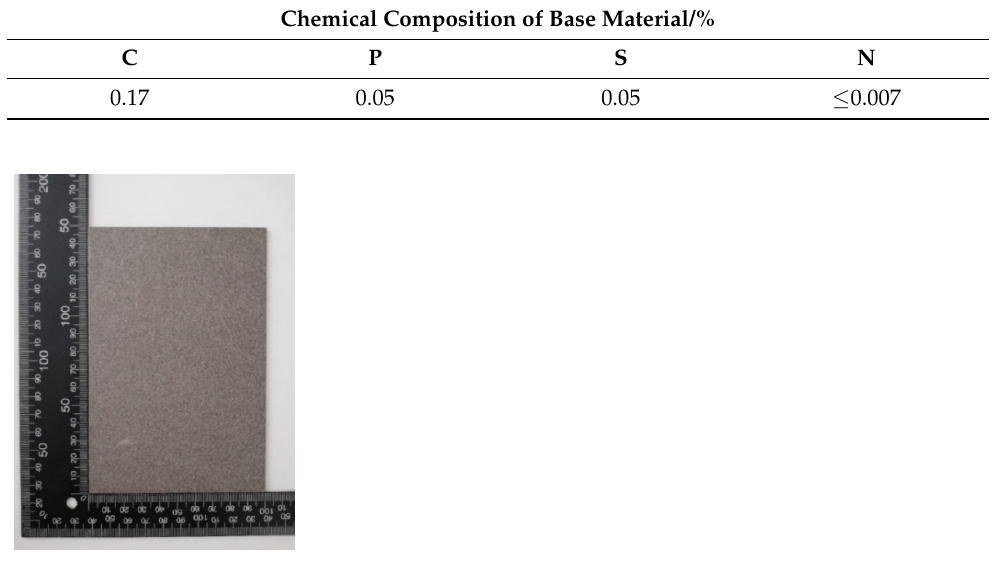
Figure 2. Test sample after abrasive jet treatment.